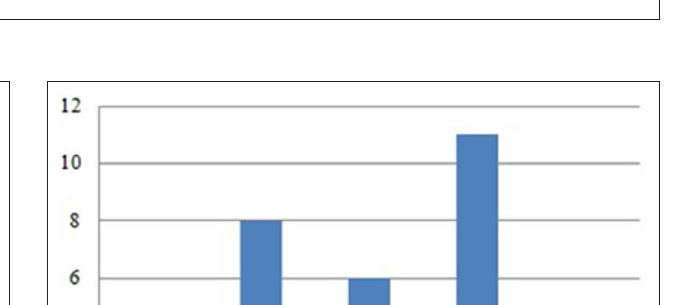
FIGURE 2 | Types of tumors present in our records.